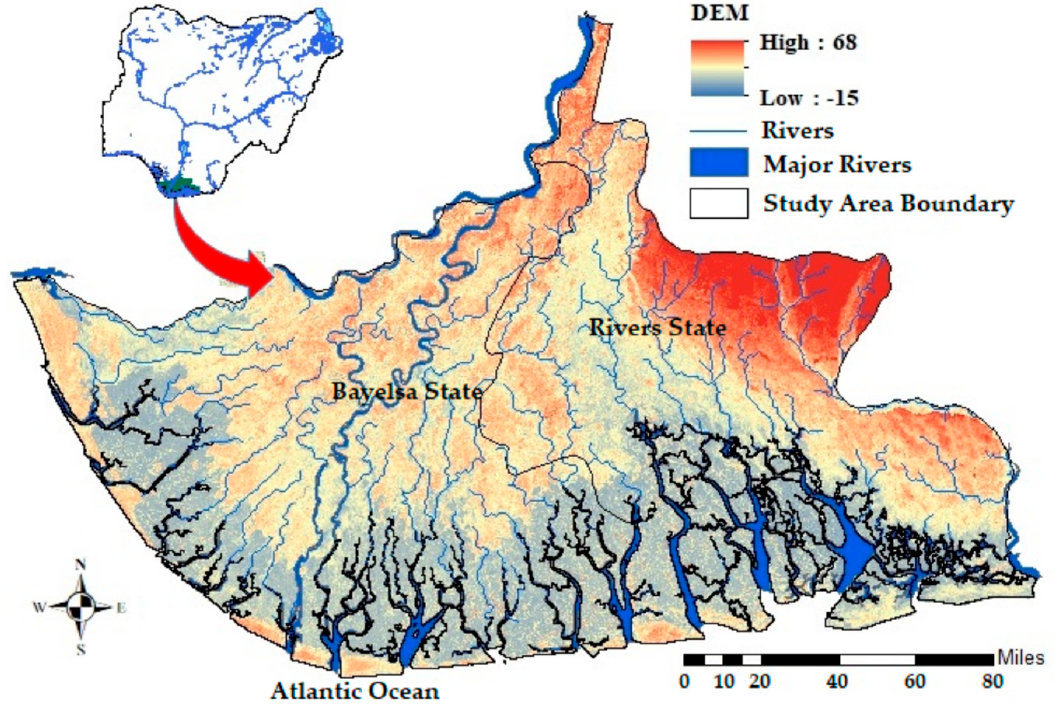
Figure 1. Digital elevation map showing the location of the study area in Nigeria.